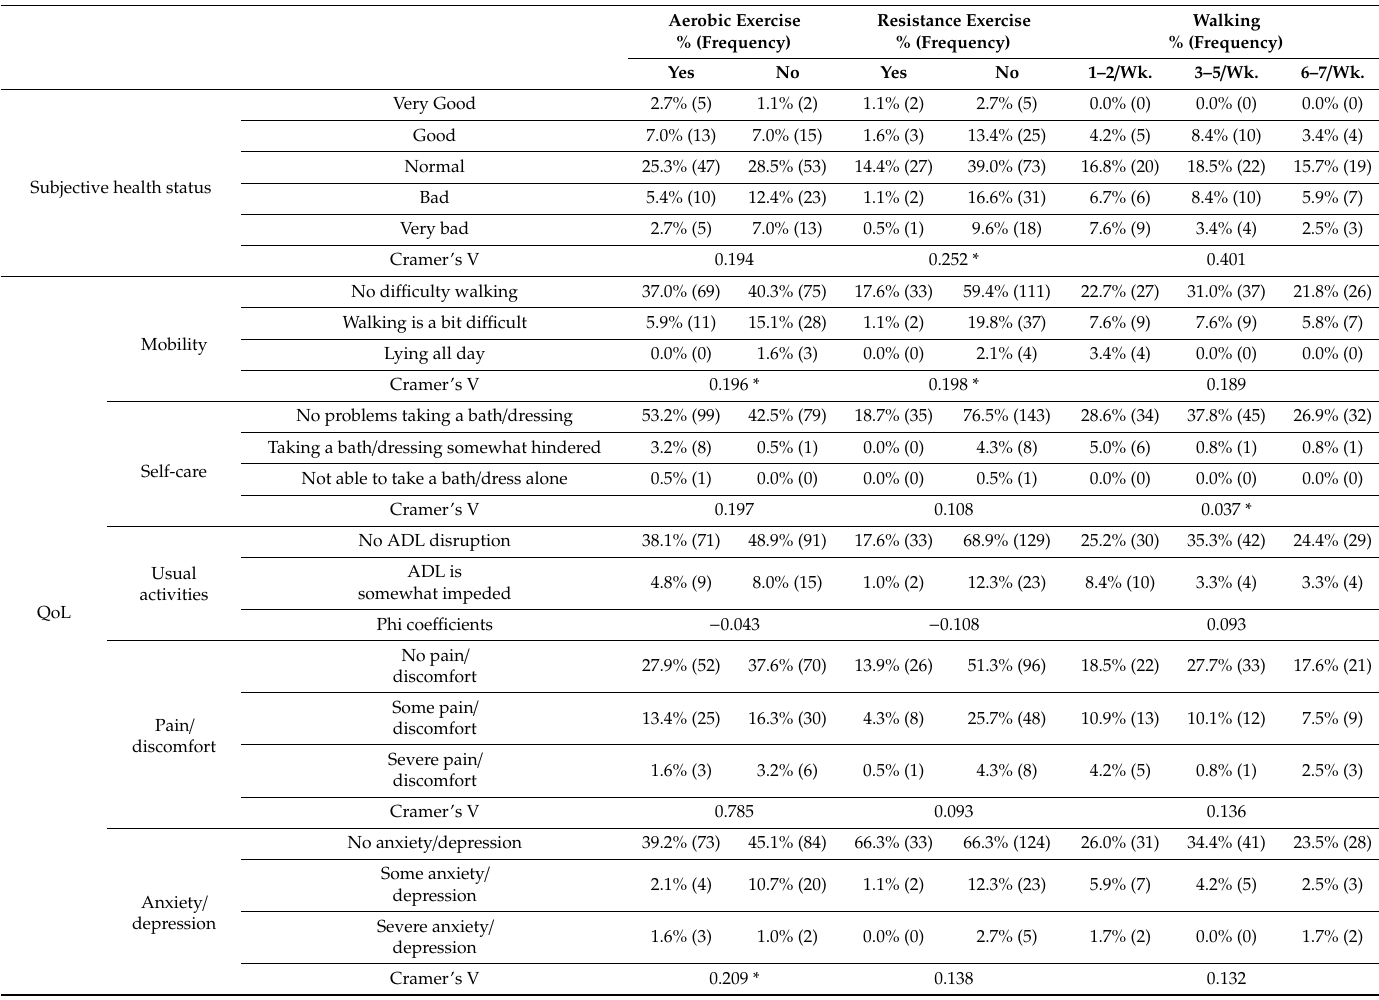
Table 3. Correlation between exercise modality, subjective health status and QoL in breast cancer